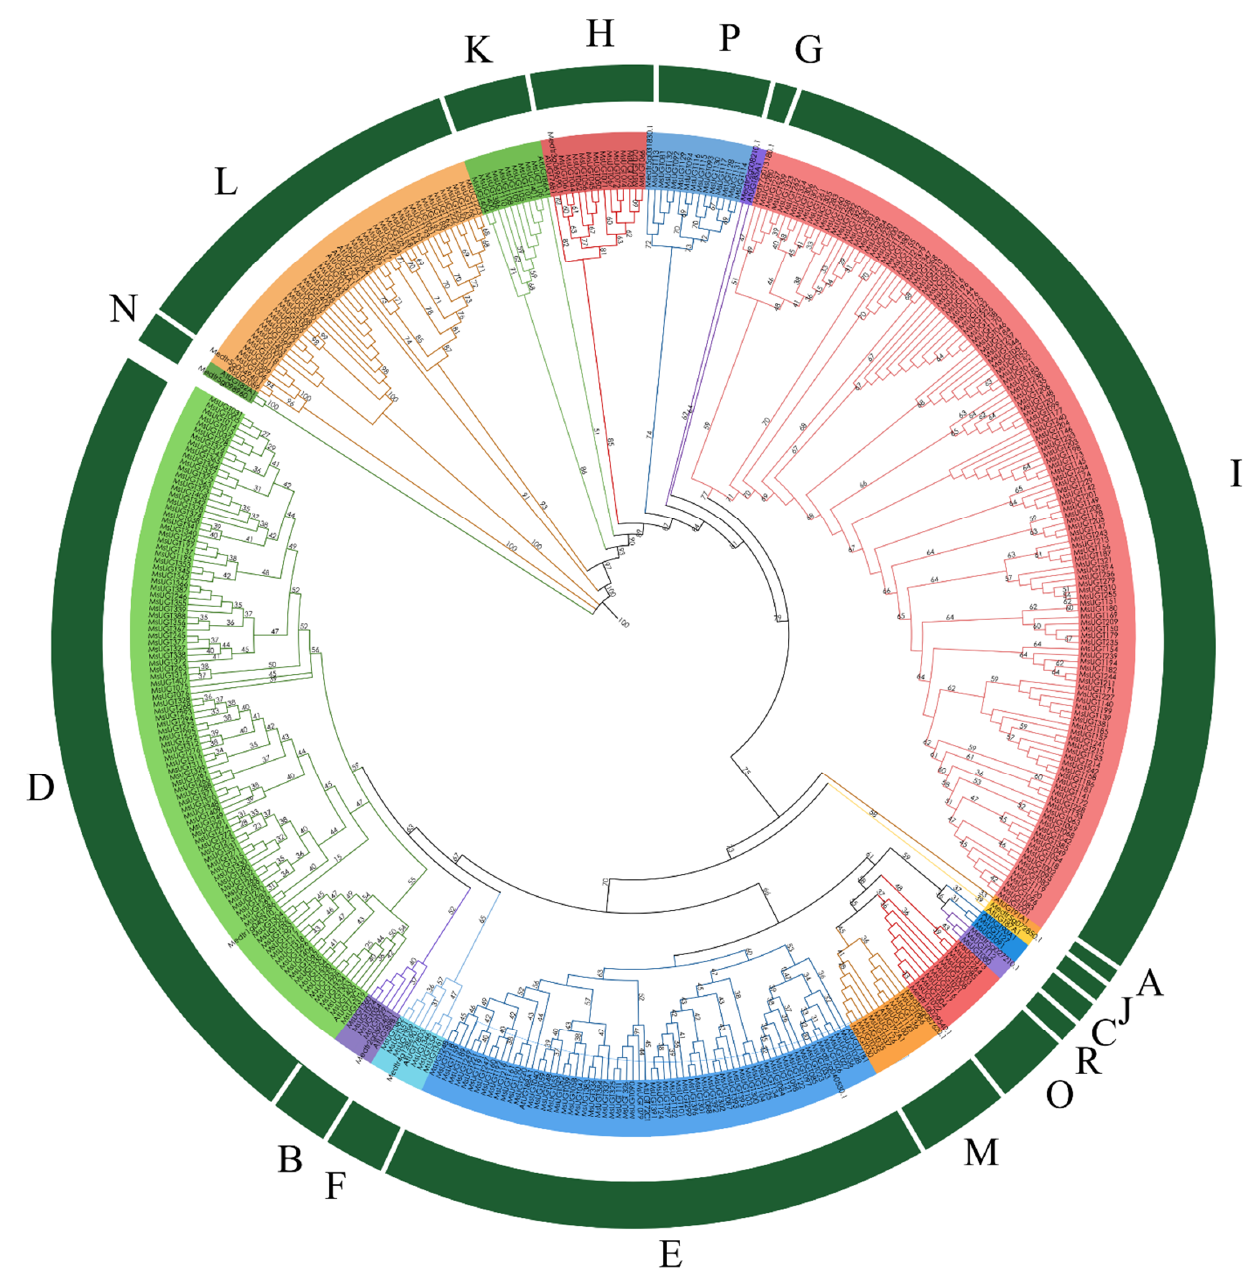
Figure 1. Phylogenetic tree of UGTs from alfalfa, A. thaliana and M. truncatula . 17 A. thaliana UGTs members and 14 M. truncatula and 409 identified UGTs from alfalfa were contracted the phylogenetic trees using the MEGA 7 program. These members were clustered into 17 groups (A–N, and O, P, R), and indicated by different colors.